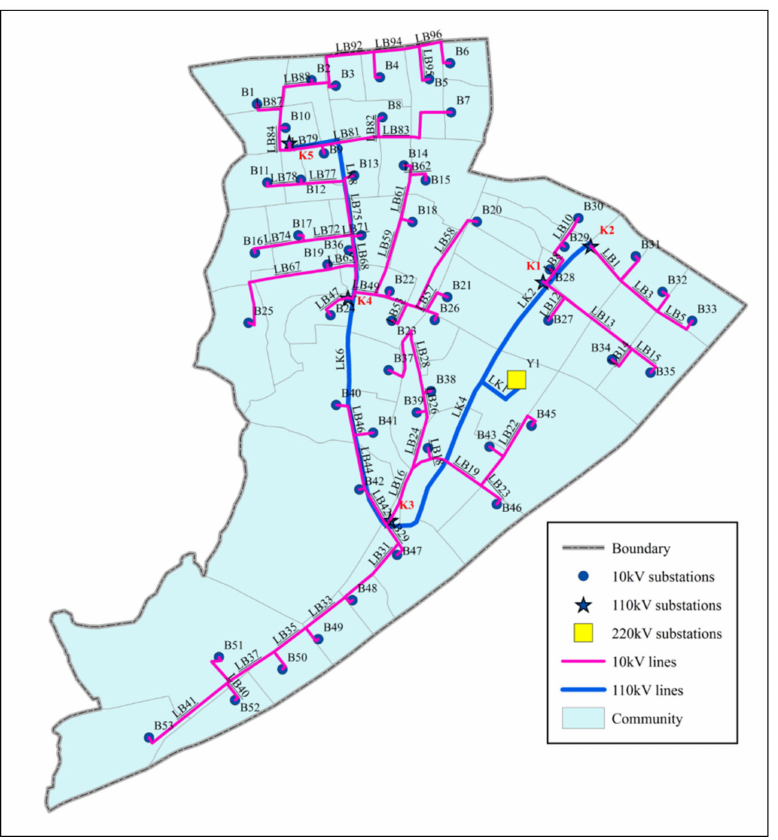
Figure 4. Plan of the virtual power supply network.